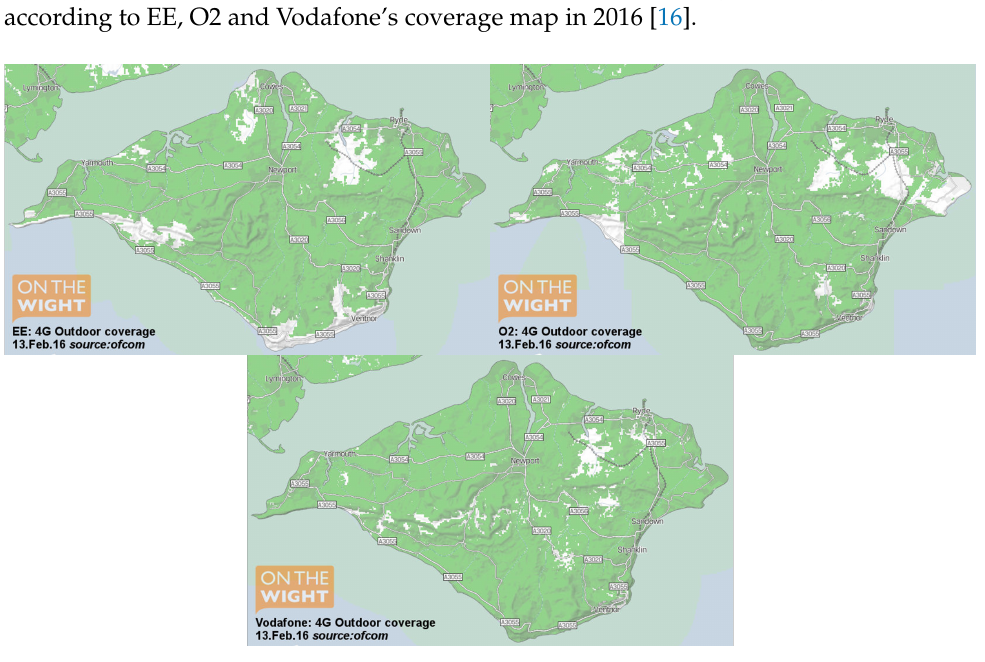
Figure 2. 4G coverage on the Isle of Wight, green shows the respective coverage of EE, O2 and Vodafone